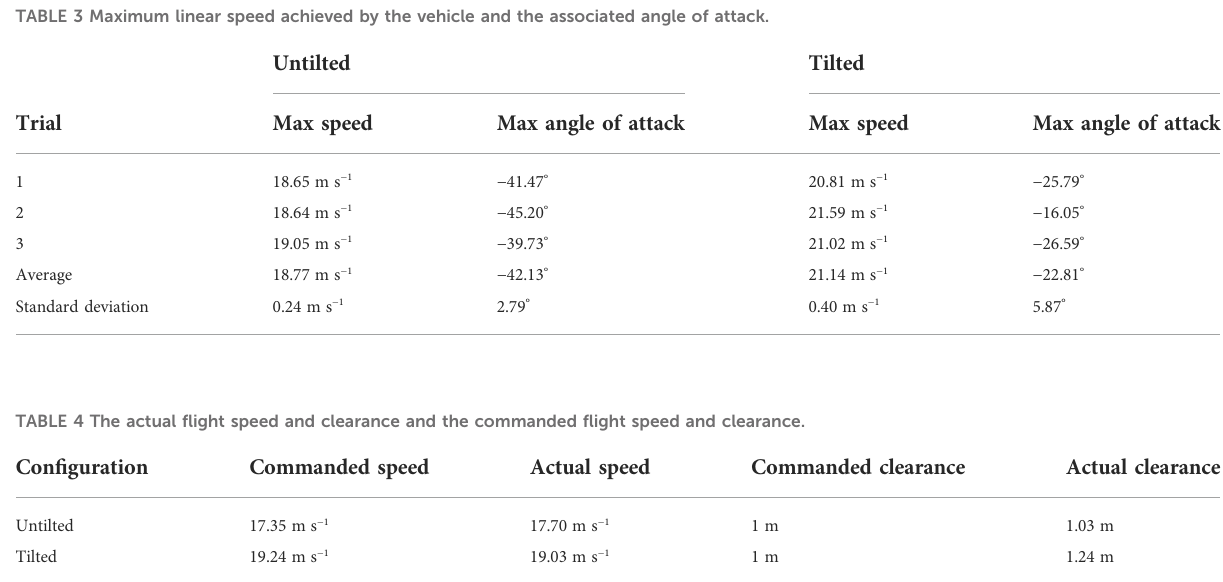
TABLE 3 Maximum linear speed achieved by the vehicle and the associated angle of